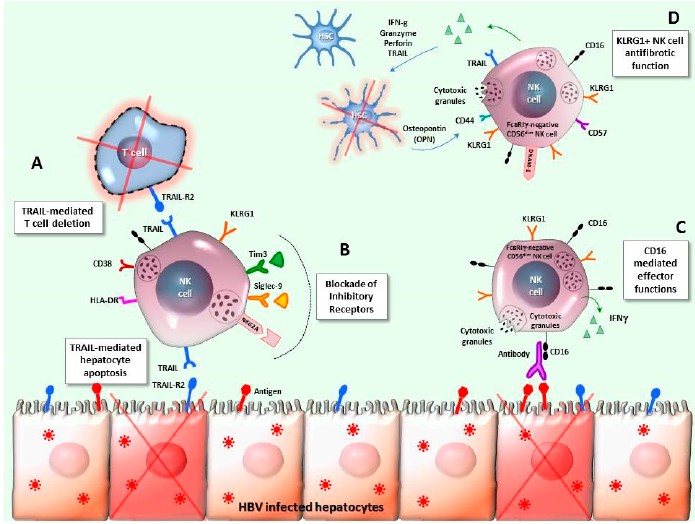
Figure 1. NK cell features in chronic HBV infection. A: The interaction between TRAIL, which is up-regulated on intrahepatic NK cells, and its receptors represents a mechanism for NK cell-mediated lysis of HBV-infected hepatocytes, but also a pathway leading to the deletion of HBV-specific T cells overexpressing the TRAIL-R2 receptor. B: The NK cell dysfunction observed in CHB infection has been targeted by correction interventions based on up-regulated inhibitory receptors blockade, like Tim-3, NKG2A, and Siglec-9. C: Fc ε RI γ -negative memory-like CD56 dim NK cells have been detected in patients with chronic HBV infection, particularly in those co-infected with HCMV, as compared with healthy donors. This NK cell subset shows increased CD16-mediated effector functions and a distinct metabolic and epigenetic signature. D: KLRG1+ NK cells displaying a mature phenotype, with elevated CD57 and DNAM-1 expression, have been found enriched in CHB patients, within the Fc ε RI γ -negative memory-like CD56 dim NK cell subpopulation. Such cells can be stimulated by osteopontin (OPN), produced by activated hepatic stellate cells (HSC), and exert an anti-fibrotic effect by killing HSC in a TRAIL-dependent manner.